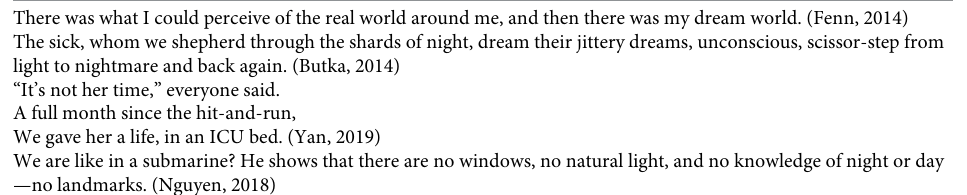
Table 3. Quotation for the sub-theme 2: Bridging Two Worlds.